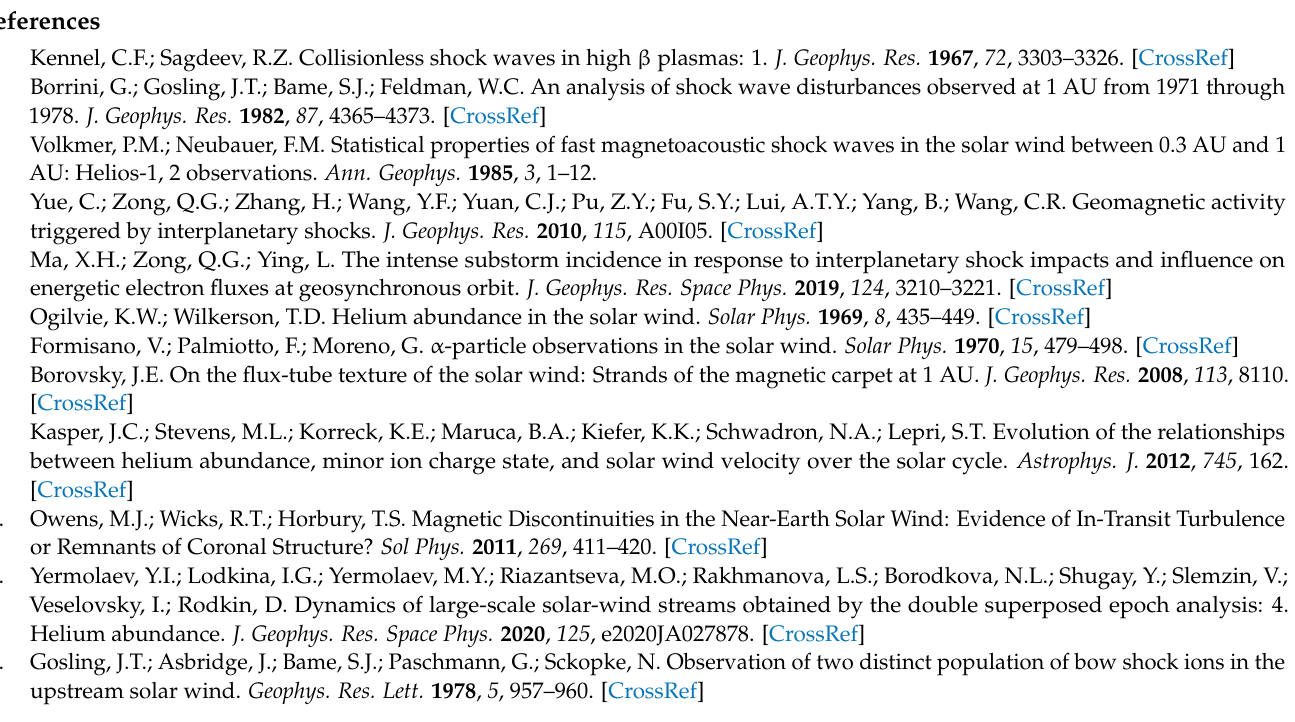
The 3DP instrument and BMSW instrument have some discrepancy due to difference in measurement methods. Also, the 3DP instrument gave lower values at the beginning of the operation of the SPEKTR-R satellite and later was recalibrated, which greatly reduced this discrepancy in absolute